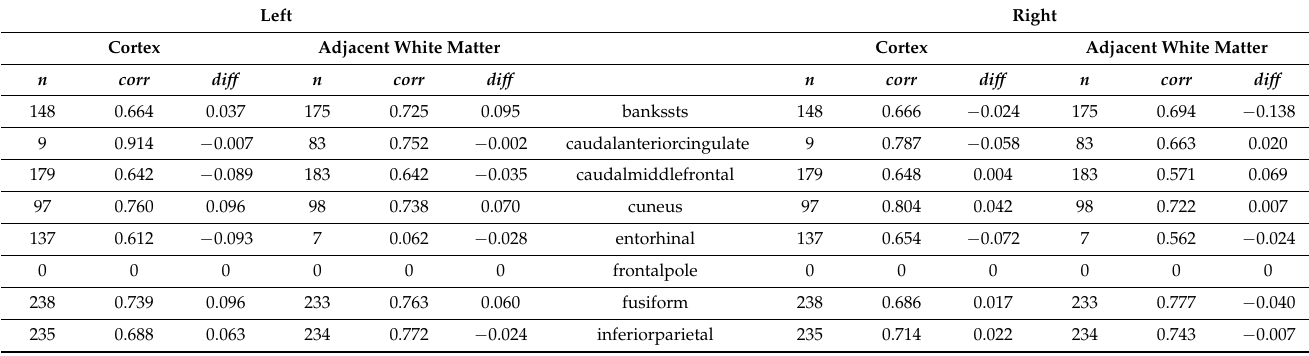
Table A2. Test-retest reliability for measures with random forest empty-room correction. n = 245. The regional measures of neuroelectric activity for 68 cortical and 68 adjacent white matter regions were extracted from both the baseline ( n = 613) and 16-month follow-up ( n = 245) CamCAN recordings. The columns labelled “corr” and “ diff. ” contain the correlation and difference between the baseline and follow-up measures. The columns labelled “ n ” show the number of subjects for whom the random forest classification yielded significant accuracy for resting vs. empty-room recordings for both baseline and